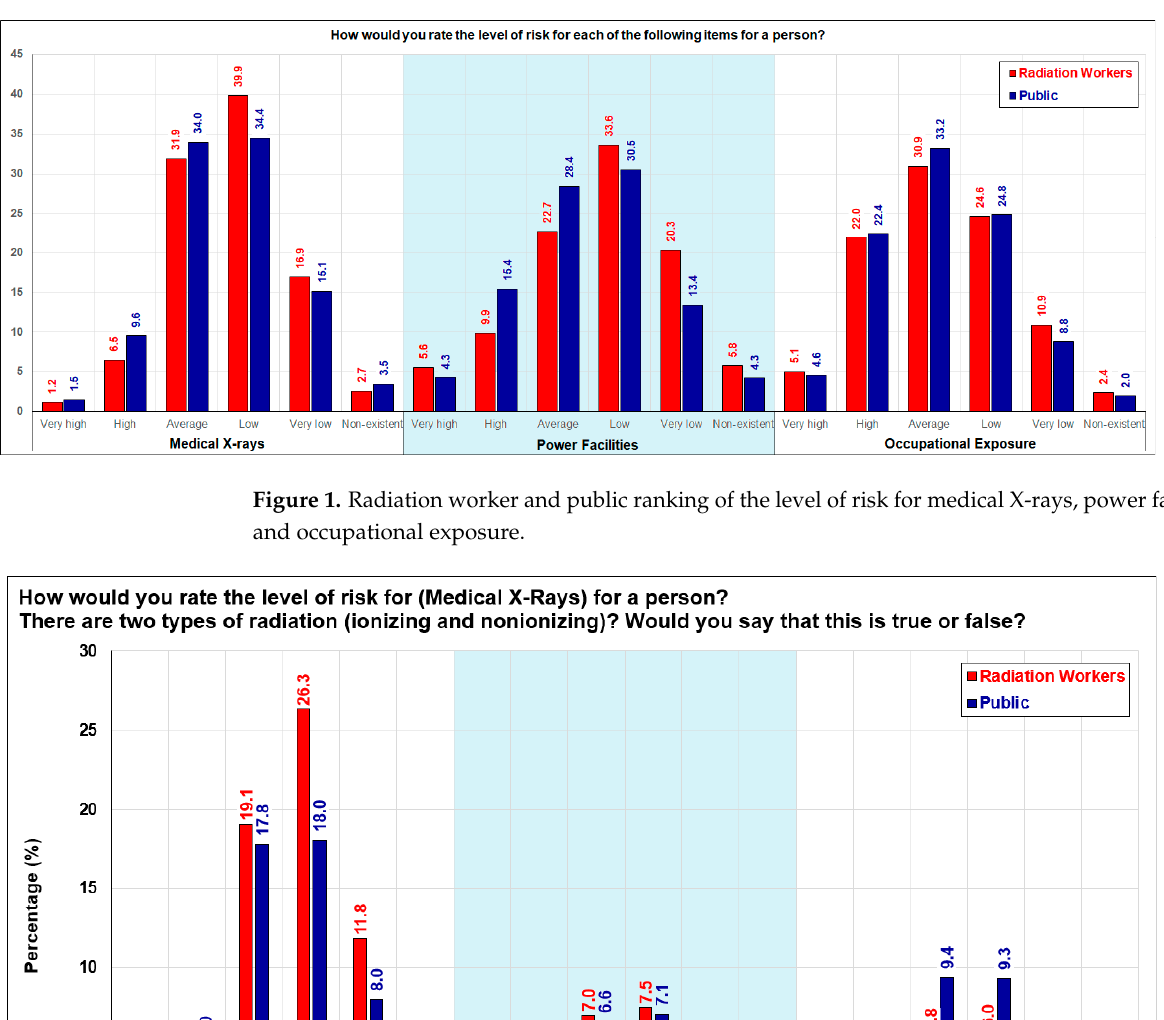
Figure 1. Radiation worker and public ranking of the level of risk for medical X-rays, power facili- ties, and occupational exposure.